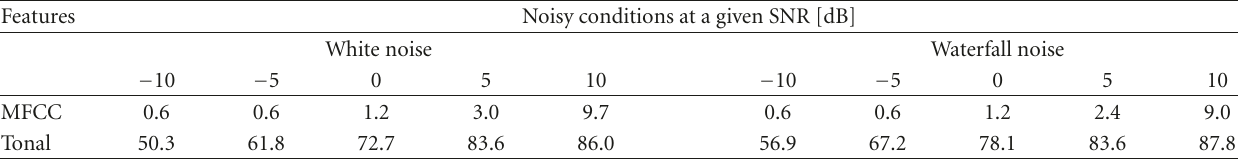
Table 2: Bird syllable recognition accuracy on noisy data obtained by the standard model employing the MFCC and tonal-based features.